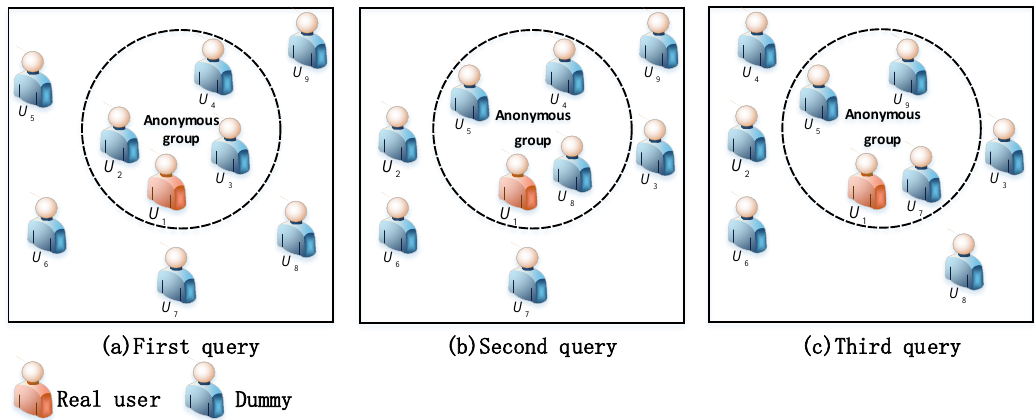
Figure 1. The same user’s continuous query request privacy in the same